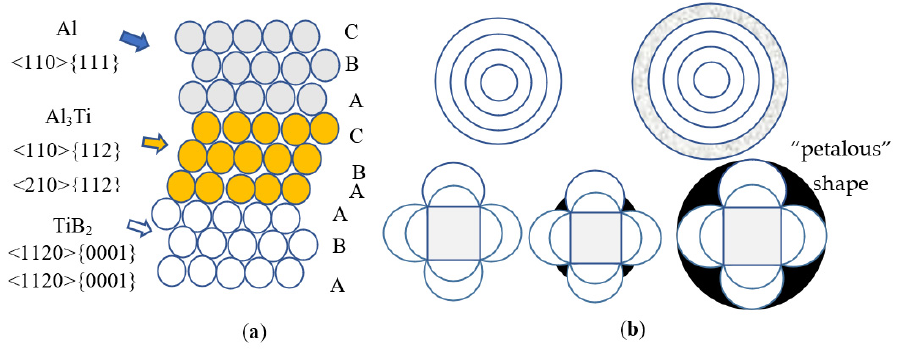
Figure 10. Grain refiner nucleation schematic diagram: ( a ) Orientation relationship between Al, Al 3 Ti, and TiB 2 ; ( b ) Nucleation diagram of Al-5Ti-0.2B and Al-3Ti-0.15C refiner during